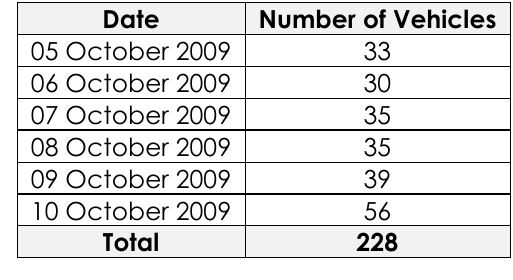
Table 1. Number of Customers Coming Over 6